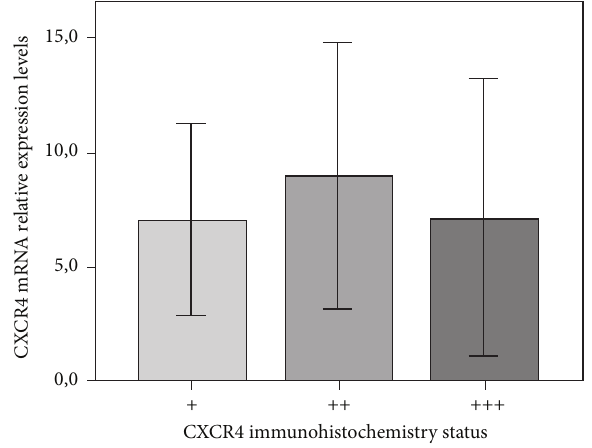
Figure 5: CXCR4 mRNA relative expression and immunohisto- chemistry status. Variance analysis tests (ANOVA) demonstrated that CXCR4 mRNA levels did not differ significantly between +/weak (mean 7.08 ± SD 6.2), ++/moderate ( 8.99 ± 7.0 ), and +++/strong( 7.18±7.3 )( 𝑝 = 0.809 )immunohistochemistrystatuses. Error bars as 95%